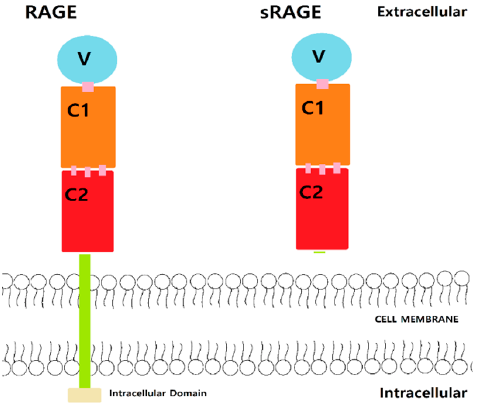
Figure 1. Structure of receptor for advanced glycation endproducts (RAGE) and soluble receptor for advanced glycation endproducts (sRAGE).